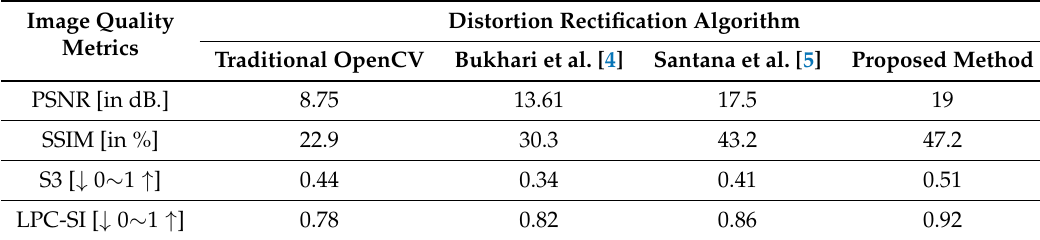
Table 2. Qualitative analysis: image quality metrics on synthetic distorted dataset.